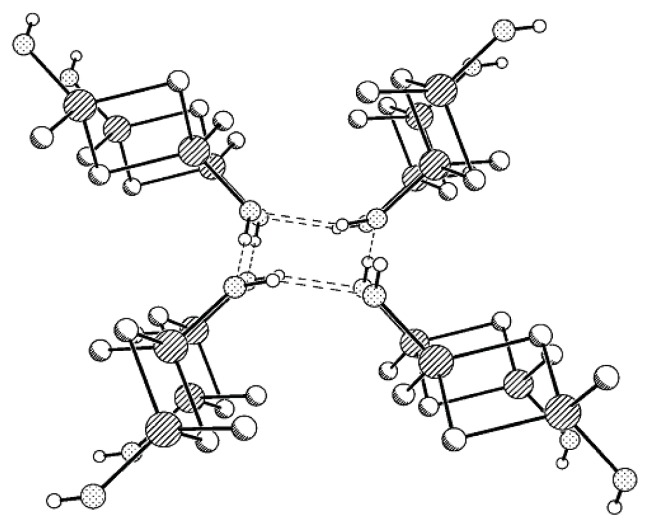
Scheme of chain packing in the crystal of Compound MX-OH.